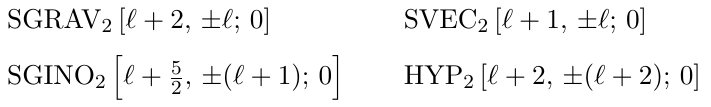
Table 1 . The protected (short, moduli independent) OSp (4 | 2) spectrum on the CM at KK levels n = 0 and ‘ ≥ 0 even. At ‘ = 0 , there is only one graviton and one vector multiplets, both of them